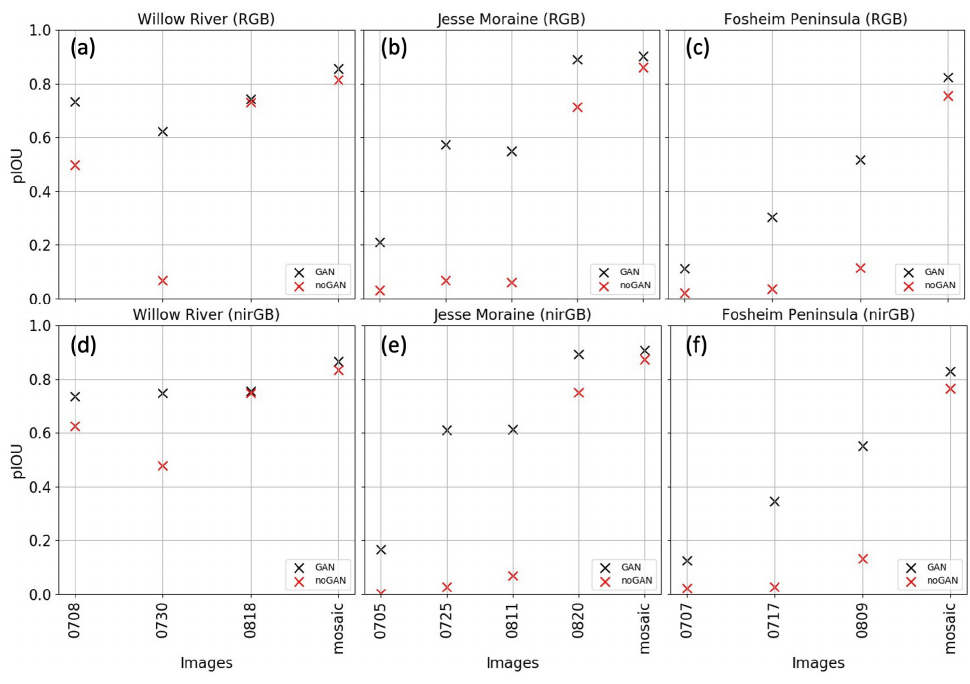
Figure 10. Comparison of the accuracy (pIOU) between experiments with and without GAN domain adaptation for images acquired on different dates. ( a – f ) show the accuracies of different regions using RGB and nirGB images. All images are from 2020 and the numbers on the x-axis (e.g., 0730) represent the acquisition month (e.g., 07) and day (e.g., 30).